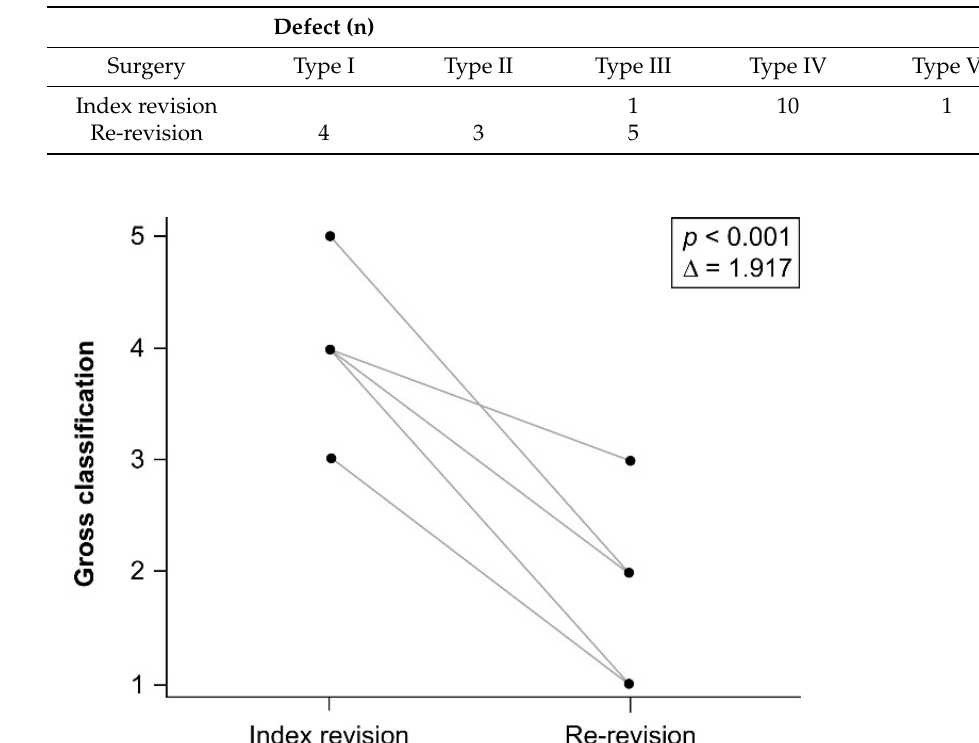
Table 2. Gross classification of acetabular bone loss at index and re-revision surgery.